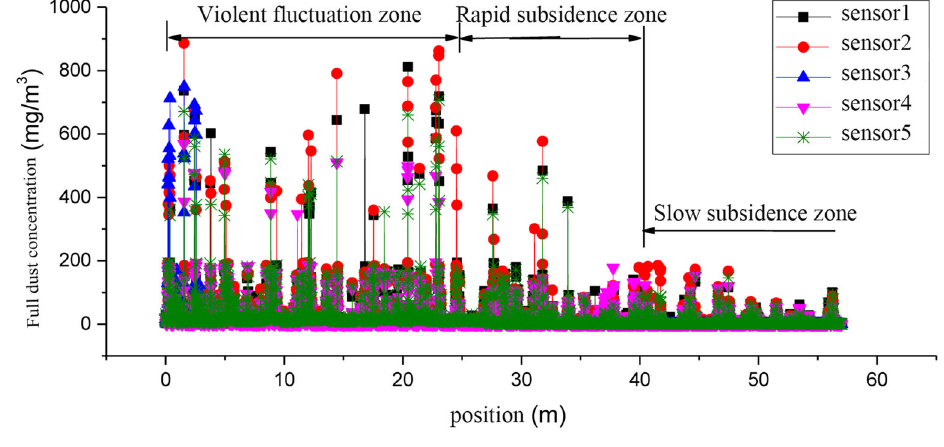
Fig. 4 Division of areas of total dust concentration